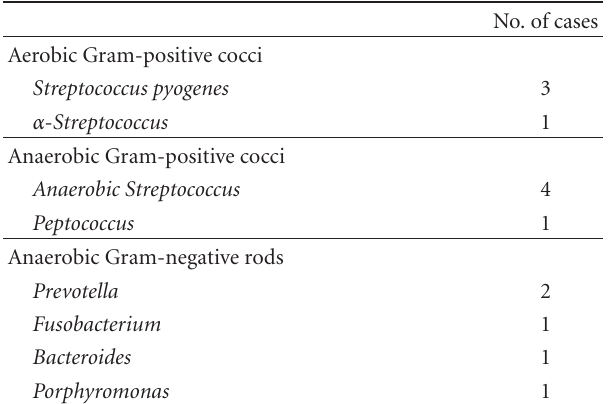
Table 2: Cultured organisms from phagocytosis—positive cases.